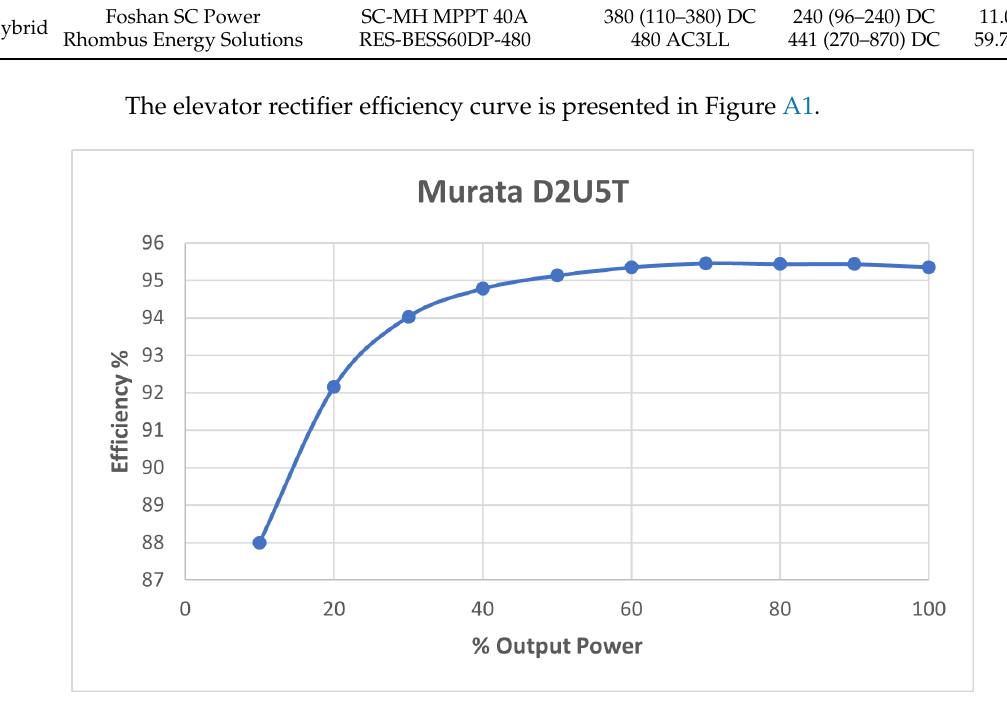
Figure A1. Efficiency curve for elevator rectifier